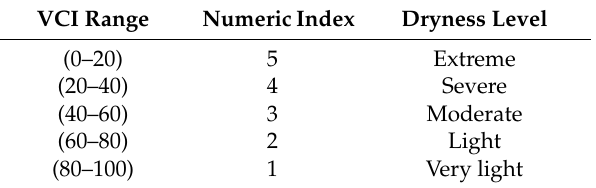
Table 3. Classification of the Vegetation Condition Index